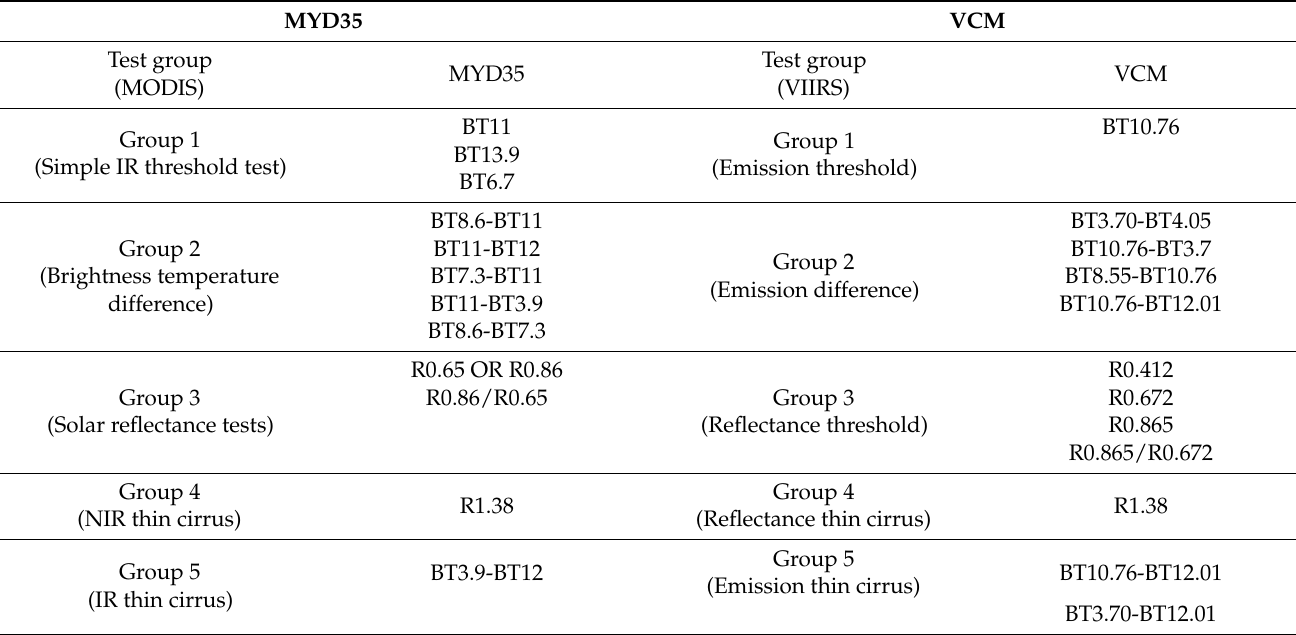
Table 3. The differences in band tests between MYD35 and VCM. Note that ‘R’ represents the calibrated top of the atmosphere reflectance, while the numbers following the letters ‘BT’ and ‘R’ are the central wavelengths in µ